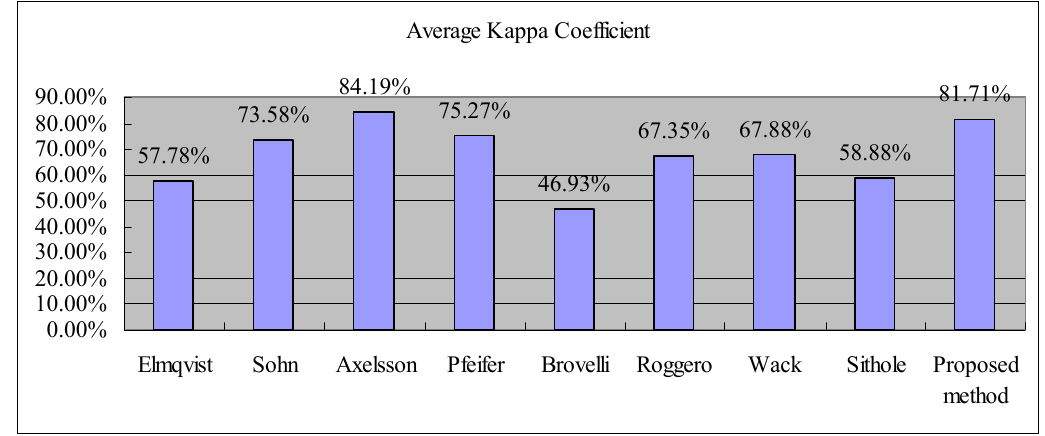
Figure 5. Comparison of average kappa coefficient of the different filtering algorithms.